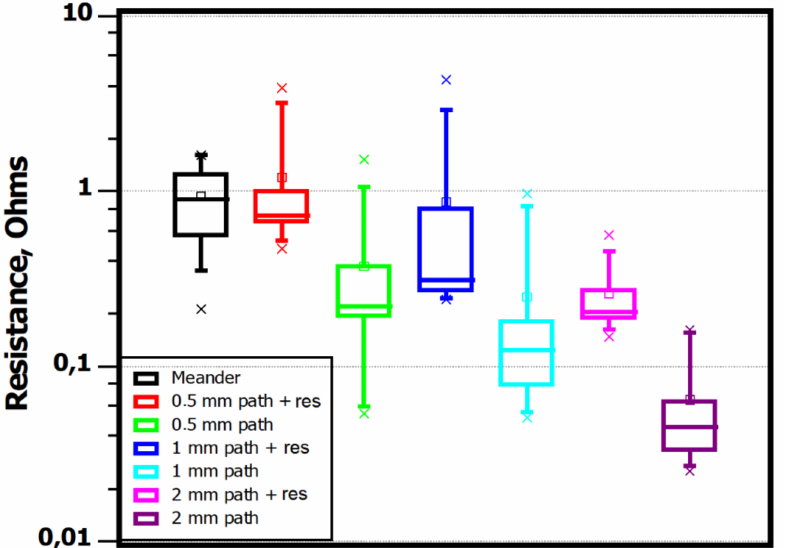
Figure 3. Initial resistance of different groups of 3D printed electronics. The designation “+ res” indicates paths with a 0 Ω